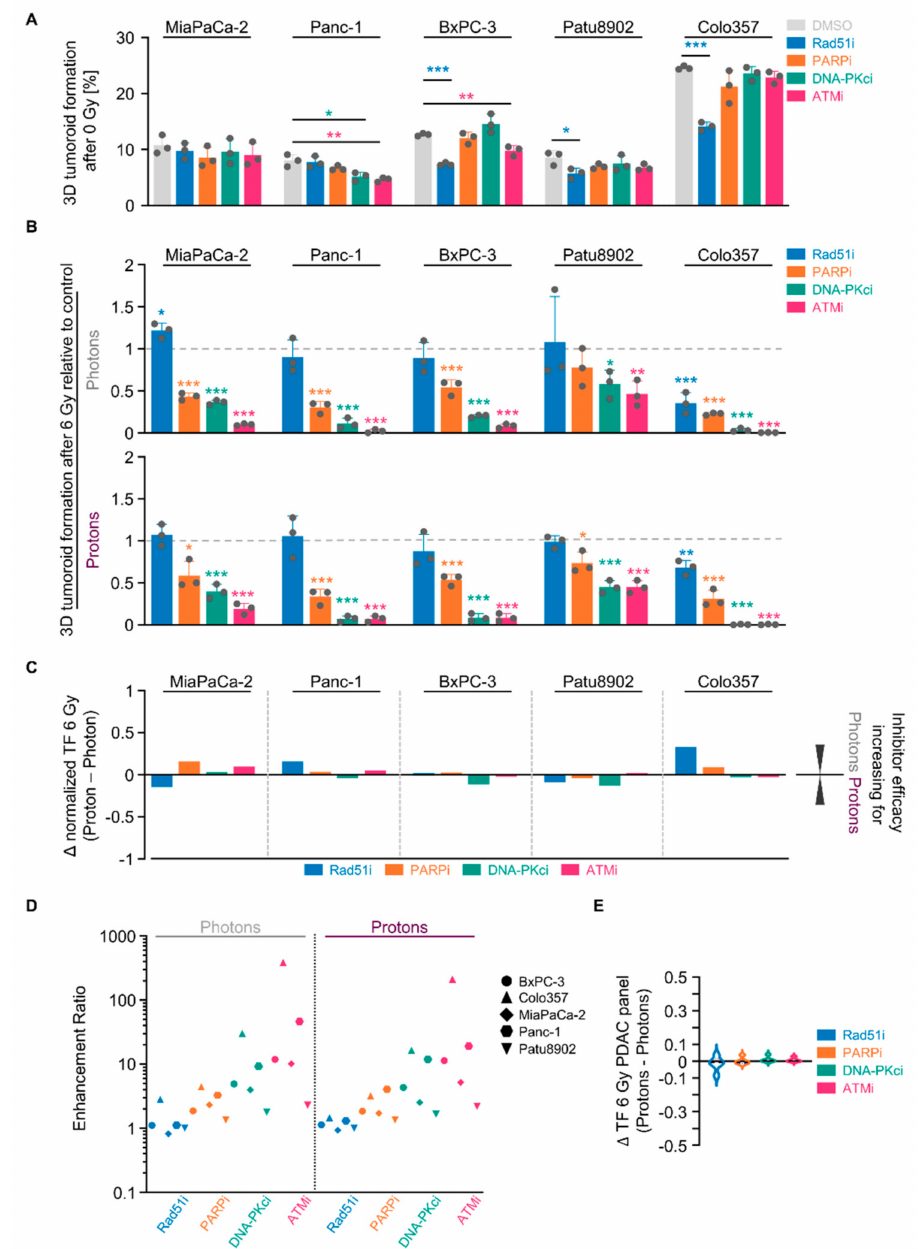
Figure 5. Targeting NHEJ-associated enzymes seems generally potent to sensitize 3D PDAC cell cultures to photon and proton irradiation. ( A ) 3D tumoroid formation capacity of unirradiated indicated PDAC cells treated with indicated DNA repair inhibitors (experimental set-up shown in Figure S2A); ( B ) Normalized 3D PDAC tumoroid formation capacity upon 1-h inhibitor pretreatment combined with 6-Gy photon or proton irradiation; ( C ) Differences in the radiosensitizing efficacy of inhibitors visualized by ∆ values of normalized tumor formation capacity (tumoroid formation capacity after 6 Gy of protons - tumoroid formation capacity after 6 Gy of photons); ( D ) Enhancement ratio (tumoroid formation capacity after 6 Gy control treatment/tumoroid formation capacity after 6 Gy inhibitor treatment) of each cell line analyzed in B (see Figure S6) after photon and proton irradiation plotted logarithmically; ( E ) Analysis of differences in the radiosensitizing efficacy of indicated inhibitors showing violin blots of summarized ∆ values of tumoroid formation capacity from all PDAC cell lines analyzed in Figure S6. All results show mean ± SD ( n = 3; two-sided t-test; *, p < 0.05; **, p < 0.01; ***, p < 0.001); ∆ : delta, TF: tumoroid